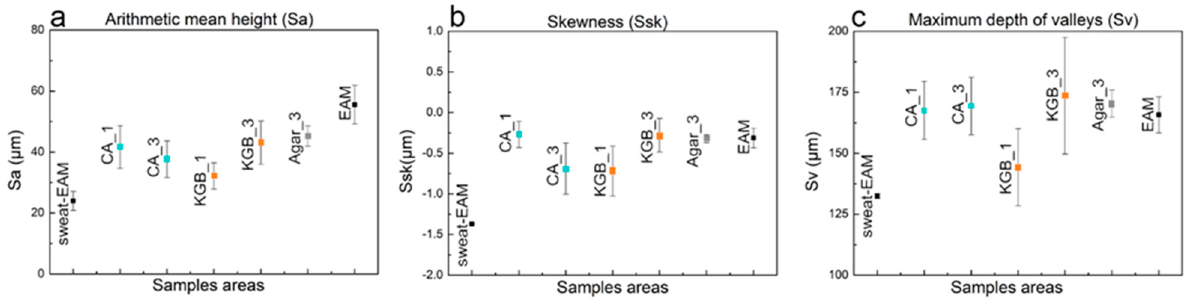
Figure 11. Considered roughness values of Sa ( a ), Ssk ( b ), and Sv ( c ) on the area of EAM and sweat − EAM cleaned by different gels and application time CA_1, CA_3, KGB_1, KGB_3, and Agar_3.